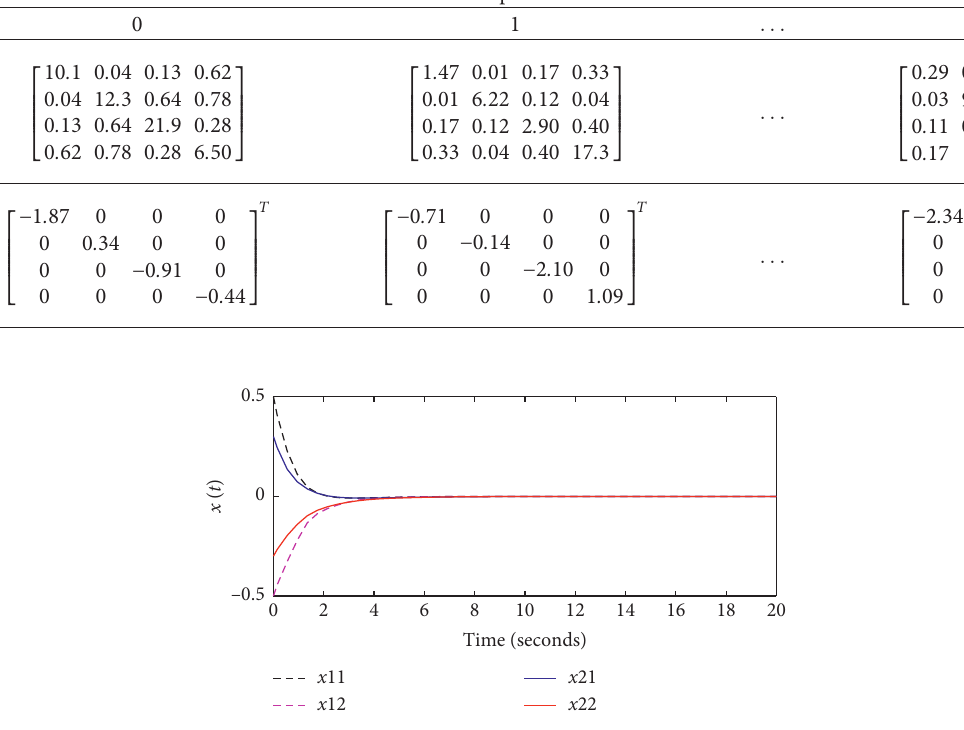
( t ) and the release instants of x 1 ( t ). k